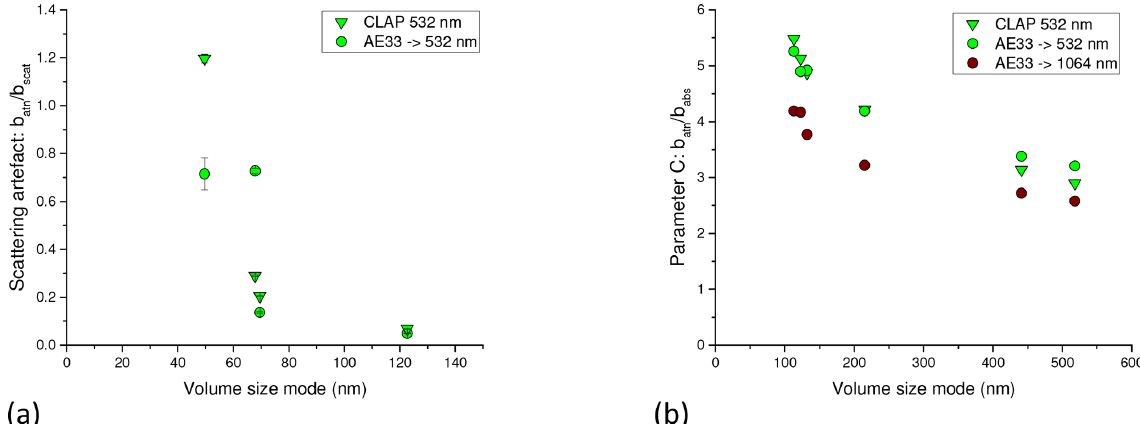
Figure 14. Scattering artefact of filter photometers for CLAP and the AE33 for different sizes of ammonium sulfate particles (a) . Multiple scattering parameter C for different sizes of soot (b) . For most measurements, the standard error was smaller than the